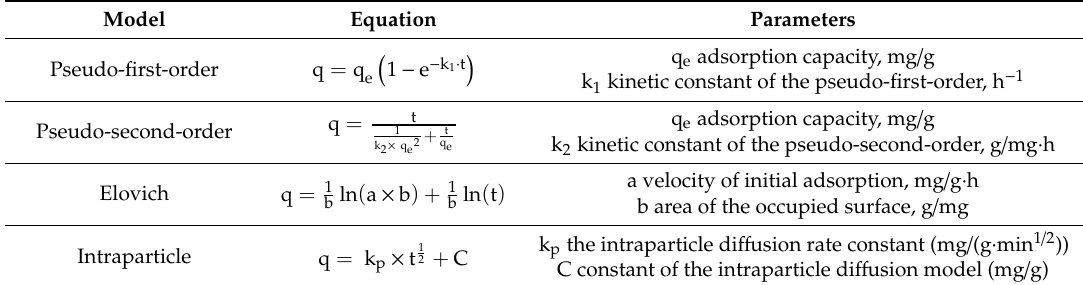
Table 2. Equations and parameters representative of the four selected kinetic models.